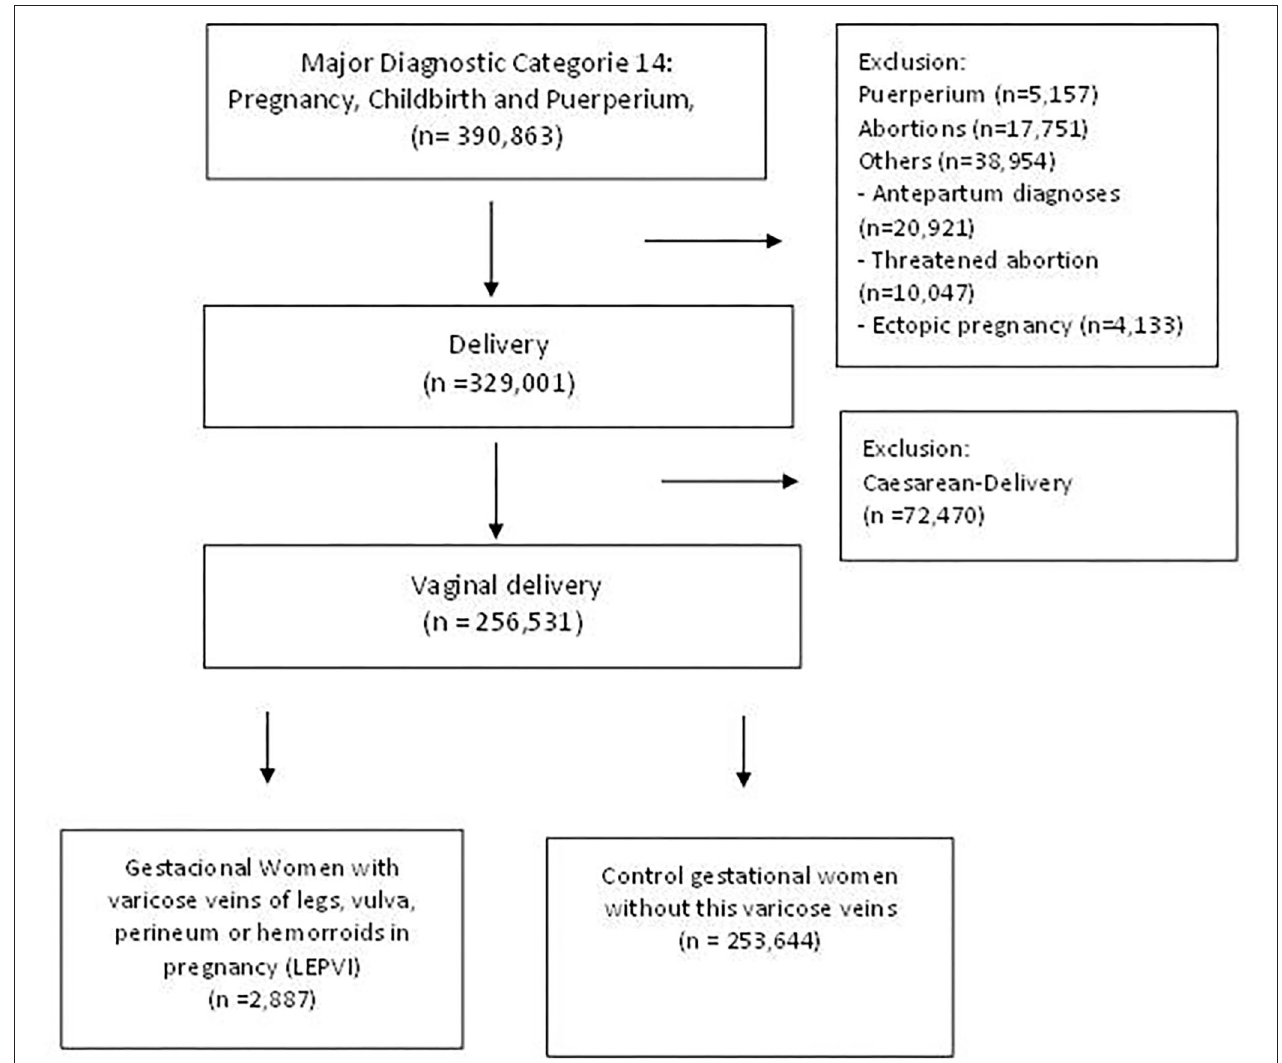
FIGURE 1 | Flowchart for the study